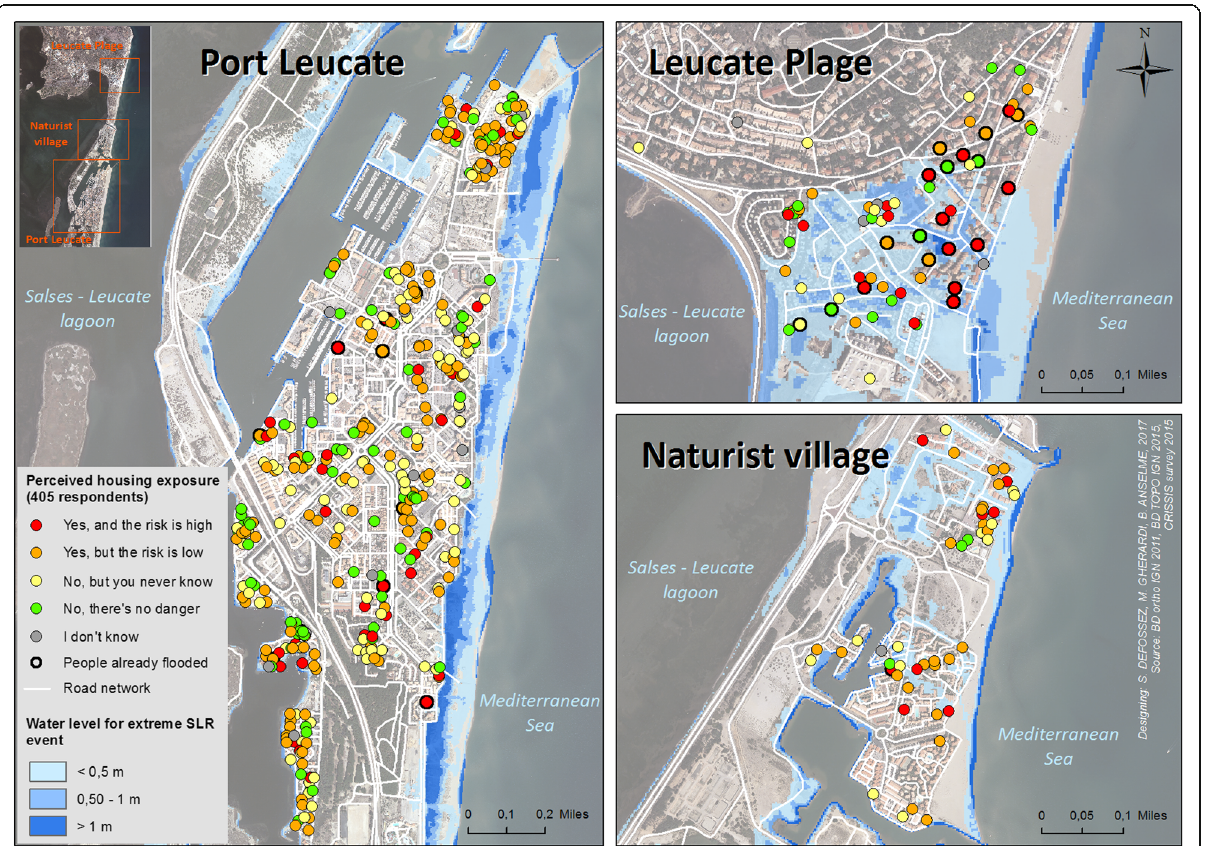
Fig. 6 Perceptions of residents on their property ’ s exposure to marine submersion